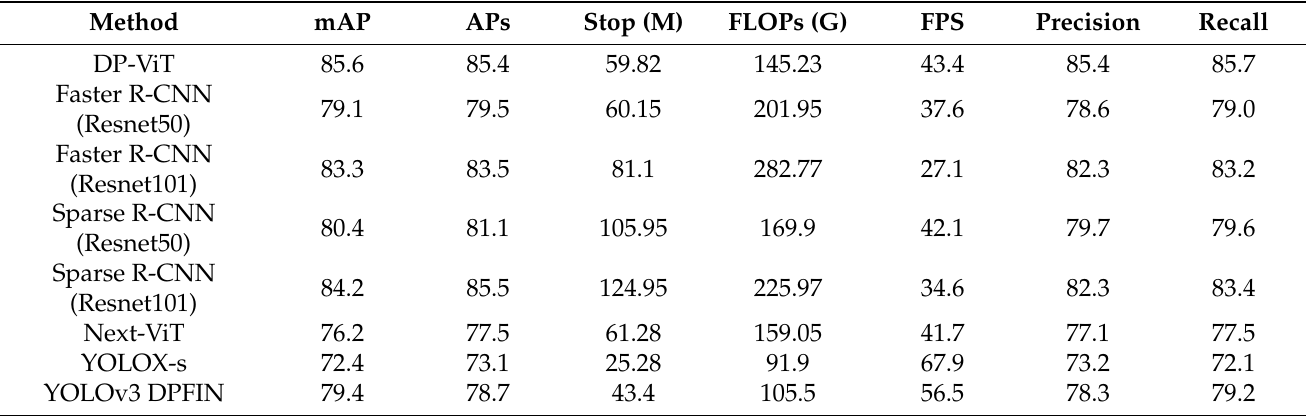
Table 4. Detection Build on Side-Scan Sonar, training and testing on Side-Scan Sonar dataset